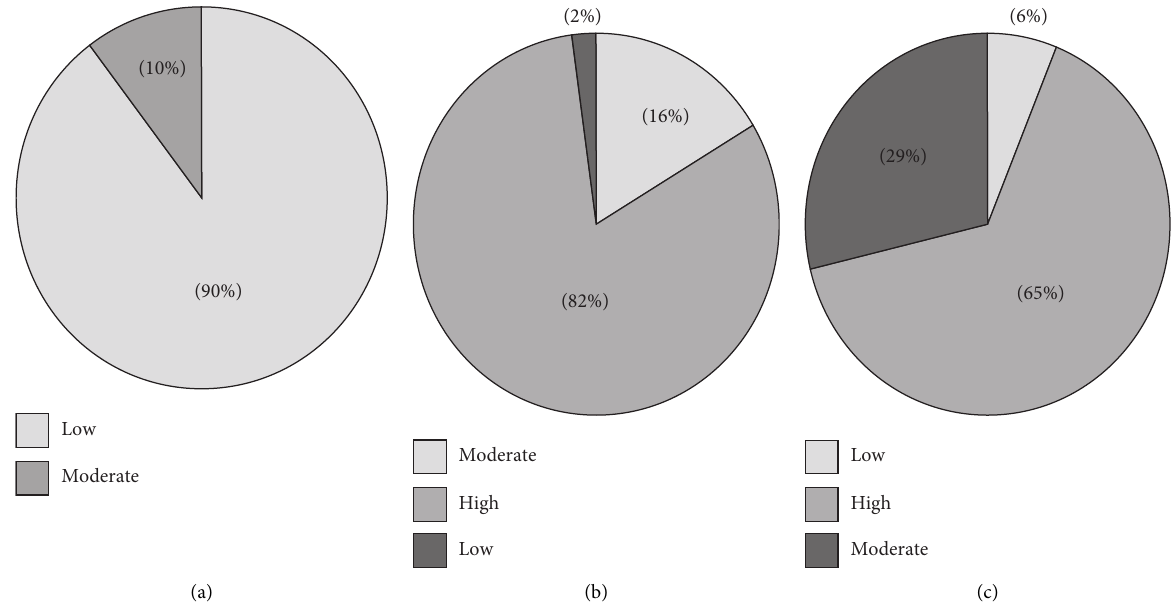
Figure 7: Sensorial characteristics of fresh fruits from 146 FFNC ecotypes. (a) Astringent. (b) Fruity. (c)